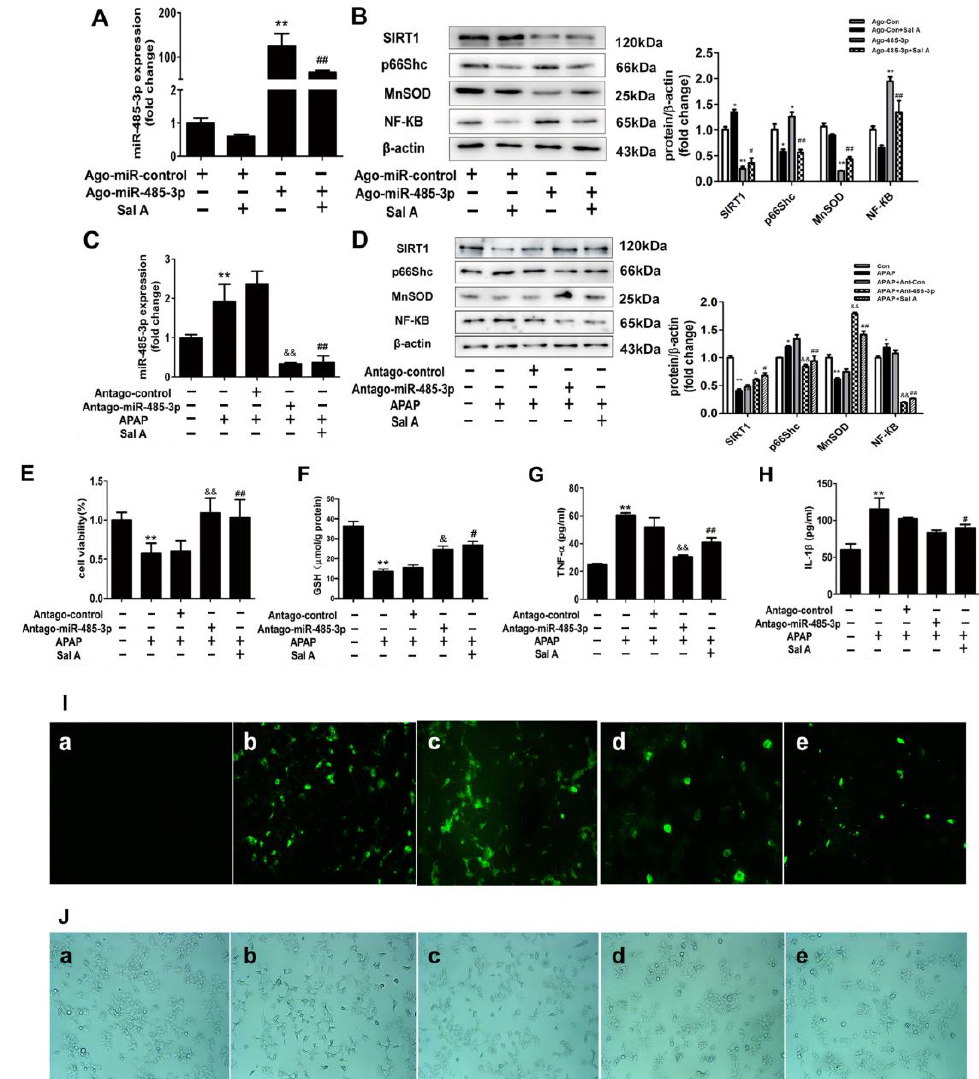
Figure 6. Sal A alleviates APAP-induced liver injury by controlling the miR-485-3p/SIRT1 pathway. ( A , B ) Ago-485-3p or negative control was transfected into AML12 cells followed by Sal A treatment. ( A ) miR-485-3p expression, n = 3. ( B ) SIRT1, p66Shc, MnSOD and NF-κB expression in AML12 cells, n = 3. ( C – I ) Antago-485-3p or the negative control was transfected into AML12 cells followed by Sal A treatment and APAP administration. ( C ) miR-485-3p expression, n = 3. ( D ) SIRT1, p66Shc, MnSOD and NF-κB expression in AML12 cells, n = 3. ( E ) Cell viability, n = 8. ( F ) GSH level in AML12 cells, n = 8. ( G , H ) TNF-α and IL-1β levels in the culture medium were determined by ELISA, n = 8. ( I ) In- tracellular ROS levels, n = 3. Intracellular ROS levels (green) in AML12 cells were determined by the fluorescent probe DCFH-DA, and ( J ) cellular morphology and structure were determined by bright image (100× magnification), n = 3: a. antago-control; b. APAP; c. antago-control+APAP; d. antago- 485-3p+APAP; e. APAP+Sal A. * p < 0.05, ** p < 0.01 vs. ago-control or antago-control; # p < 0.05, ## p < 0.01 vs. APAP or ago-485-3p, & p < 0.05, && p < 0.01 vs. APAP+ant-NC. 4. Discussion APAP is widely used as an analgesic. It is notable that APAP overdose could result in severe liver injury and even acute liver failure [1,3,4]. Except for the medication N-ace- tylcysteine (NAC), for APAP overdose patients, effective treatment methods remain lack- ing [29]. This study demonstrated that (1) inhibition of the miR-485-3p/SIRT1 pathway